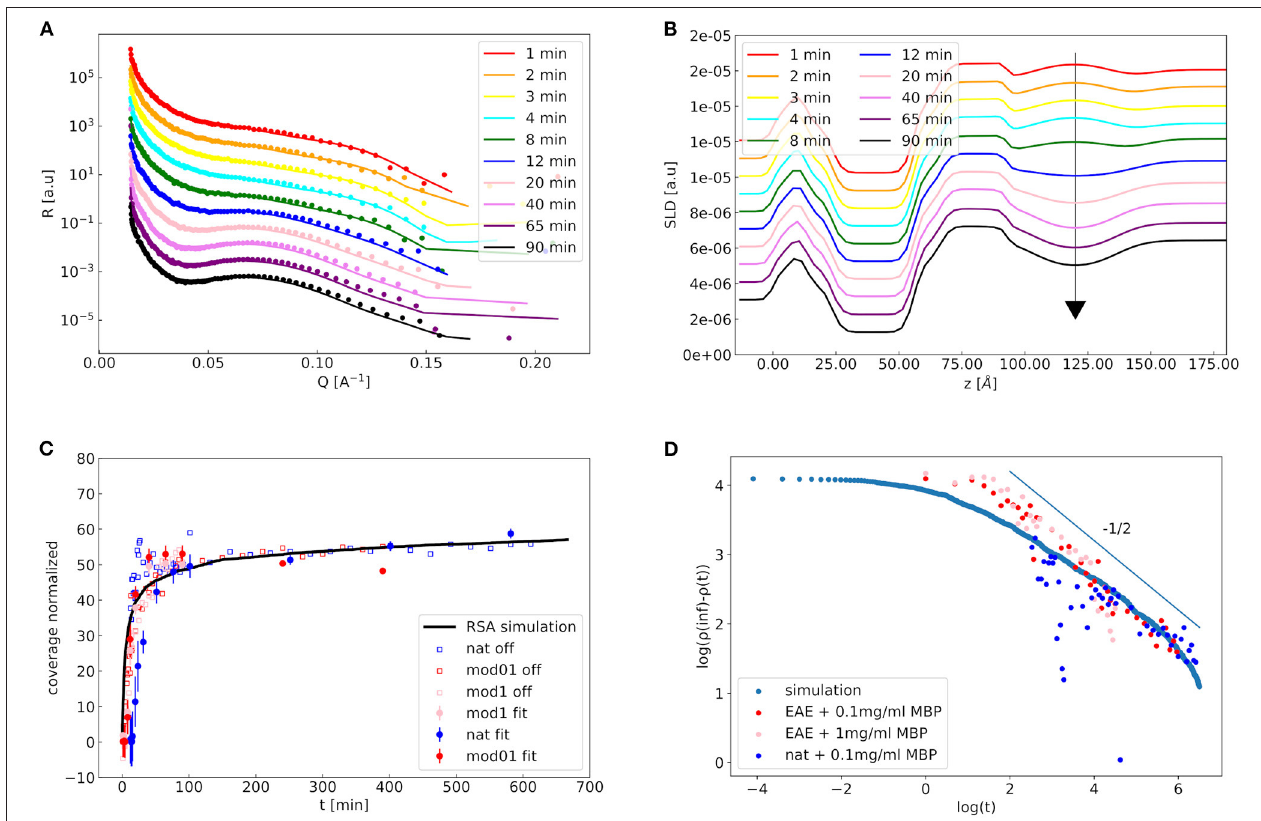
FIGURE 6 | Kinetics of the reflectivity measurements: In (A) a waterfall plot of the kinetic reflectivity measurements of the EAE modified membrane with 1 mg/ml MBP is shown (sample Modified1). Experimental NR data are represented by symbols as a function of incubation time. Solid lines are theoretical fits using the double-membrane bilayer model with intramembrane-MBP layer and diffuse vesicle layer for 3D structure of the attached vesicles. Structural parameters of the membrane profile were kept fixed during the individual fits and only the coverage fraction of the second membrane layer (and the diffuse vesicle layer water content and roughness) was fitted. In (B) the respective SLD profiles are shown. In (C) the kinetics of the off-specular signal of the three membranes (empty symbols), the kinetics of the coverage fit parameter of the three membranes obtained from specular NR data (filled symbols) and an RSA simulation of vesicles with 50nm radius and 15nm polydispersity (solid black line) are shown. In (D) the log-log-plot of the vesicle coverage ρ ( inf ) experimental values and the RSA simulation. The thin line indicates power-law behavior with a slope of flat disks on a surface ( Adamczyk et al.,